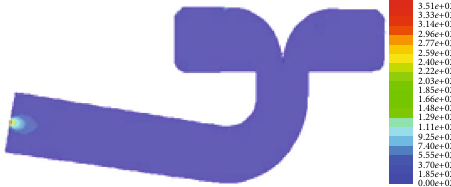
Figure 8: Contours of velocity distribution (m/s).